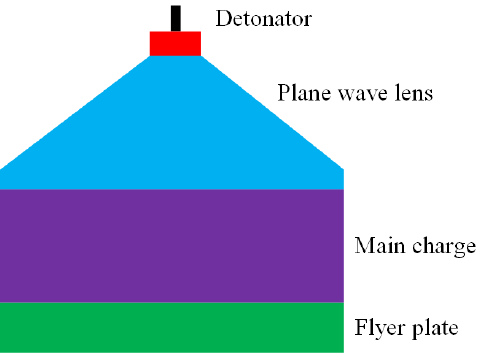
Figure 1. Schematic diagram of explosive ‐ driven flyer.